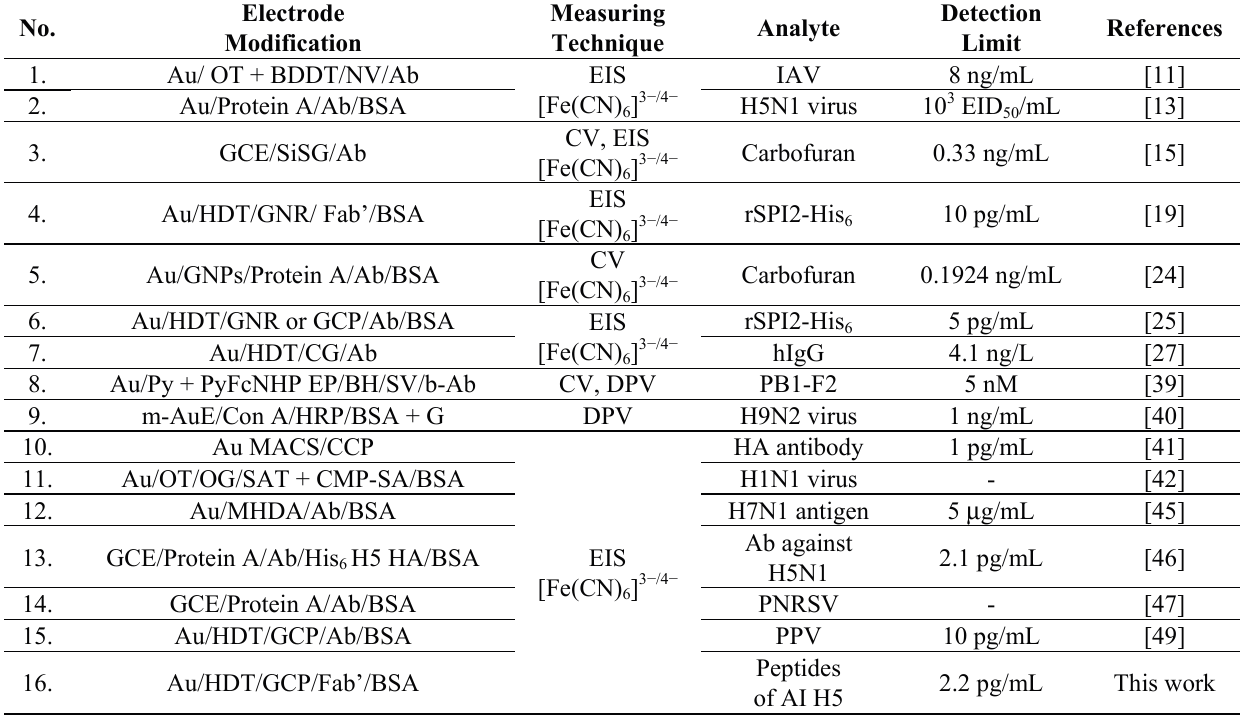
Table 1. A comparison of detection limits of electrochemical sensors destined for antigen and antibody